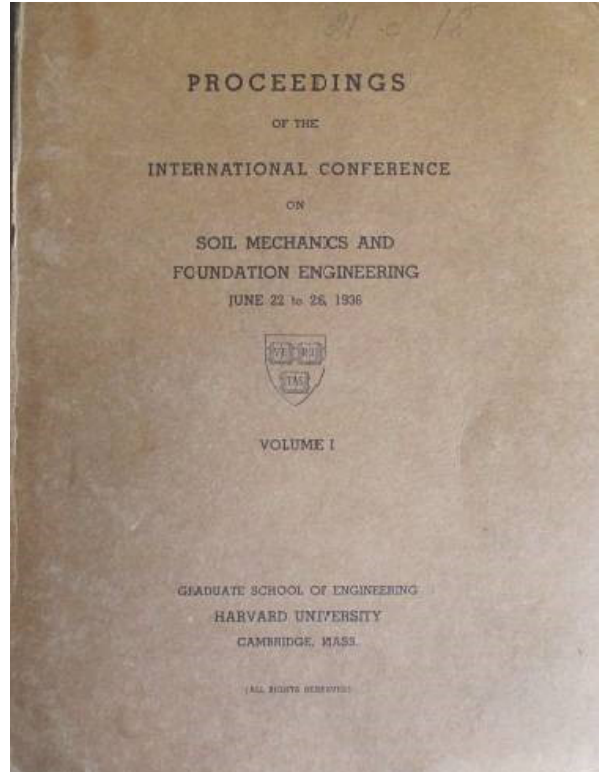
Figure 5. Detail of the cover of Volume I of the proceedings of the First International Conference on Soil Mechanics and